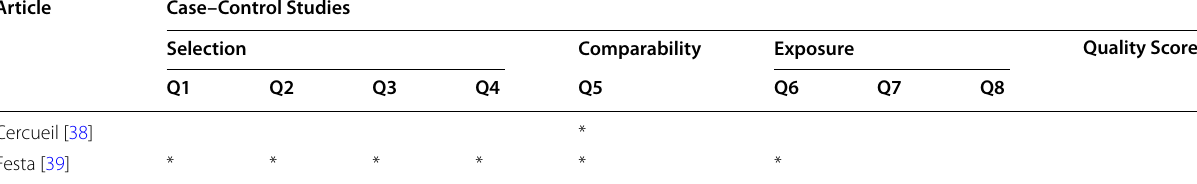
Selection: Q1. Is the case definition adequate? Q2. Representativeness of the cases? Q3. Selection of controls? Q4. Definition of